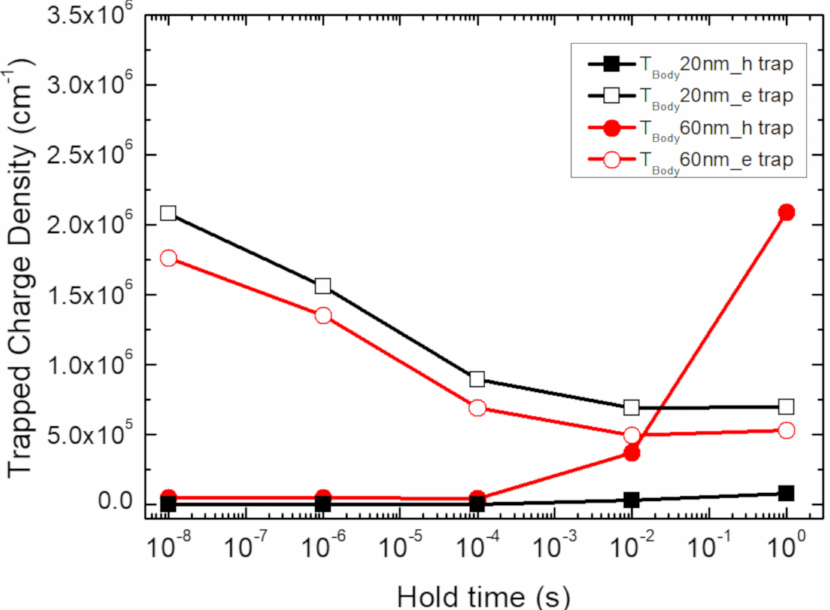
Figure 10. The trapped charge density of the T Body 20 nm and T Body 60 nm cells as a function of the hold time in Table 1. Drain voltage is 0.1